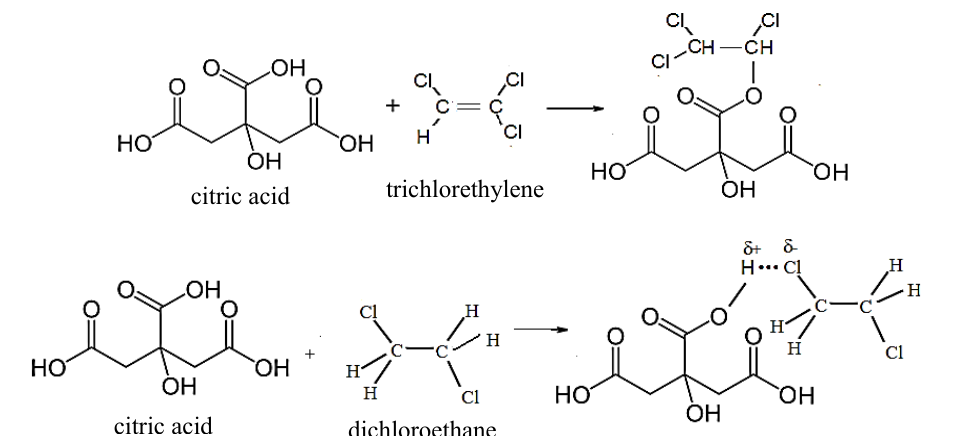
Fig. 5. Chemical interaction of contaminants with citric acid.